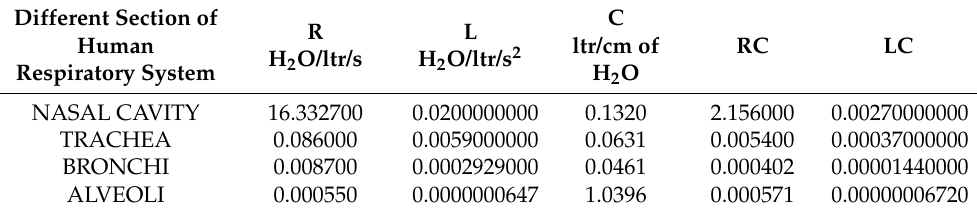
Table 2. R, L, and C